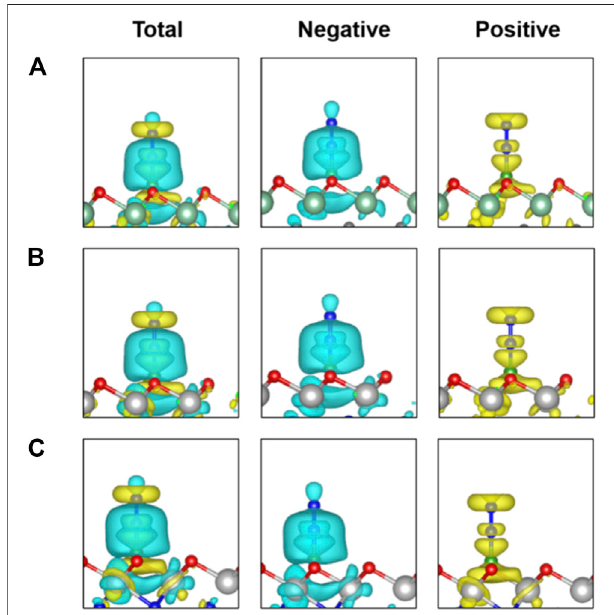
FIGURE 5 | Charge density differences of N 2 adsorbed on three B@ MXenes surfaces. The charge depletion and accumulation are depicted in cyan and yellow, respectively. The isosurface value is set to 0.001 e/Å 3 .